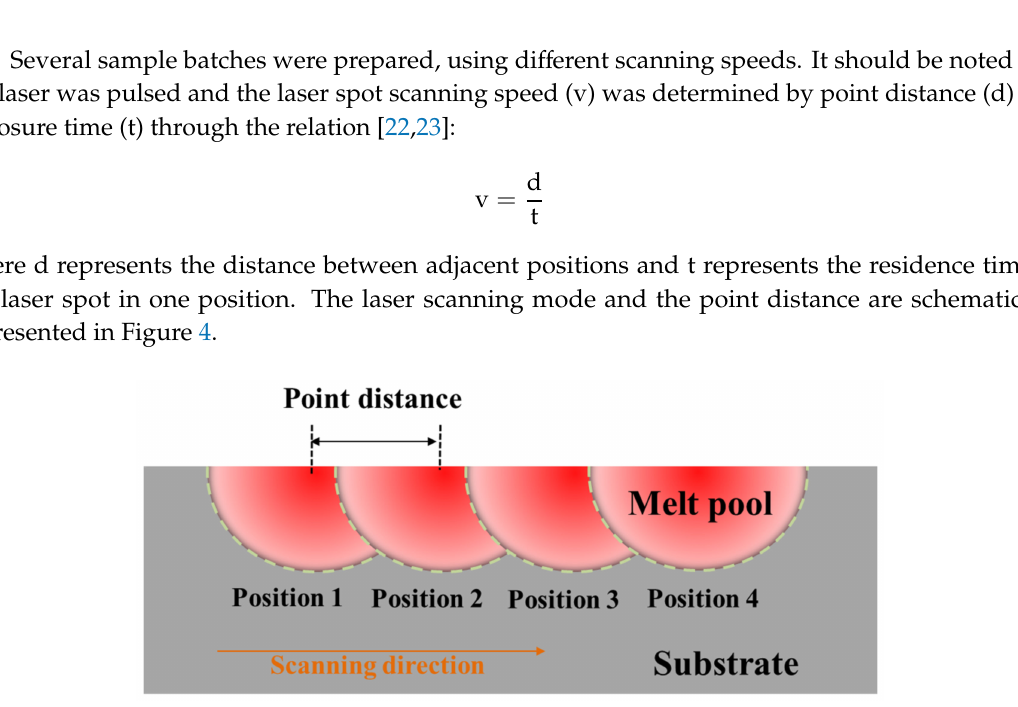
Figure 4. Schematic illustration of point distance of the pulsed